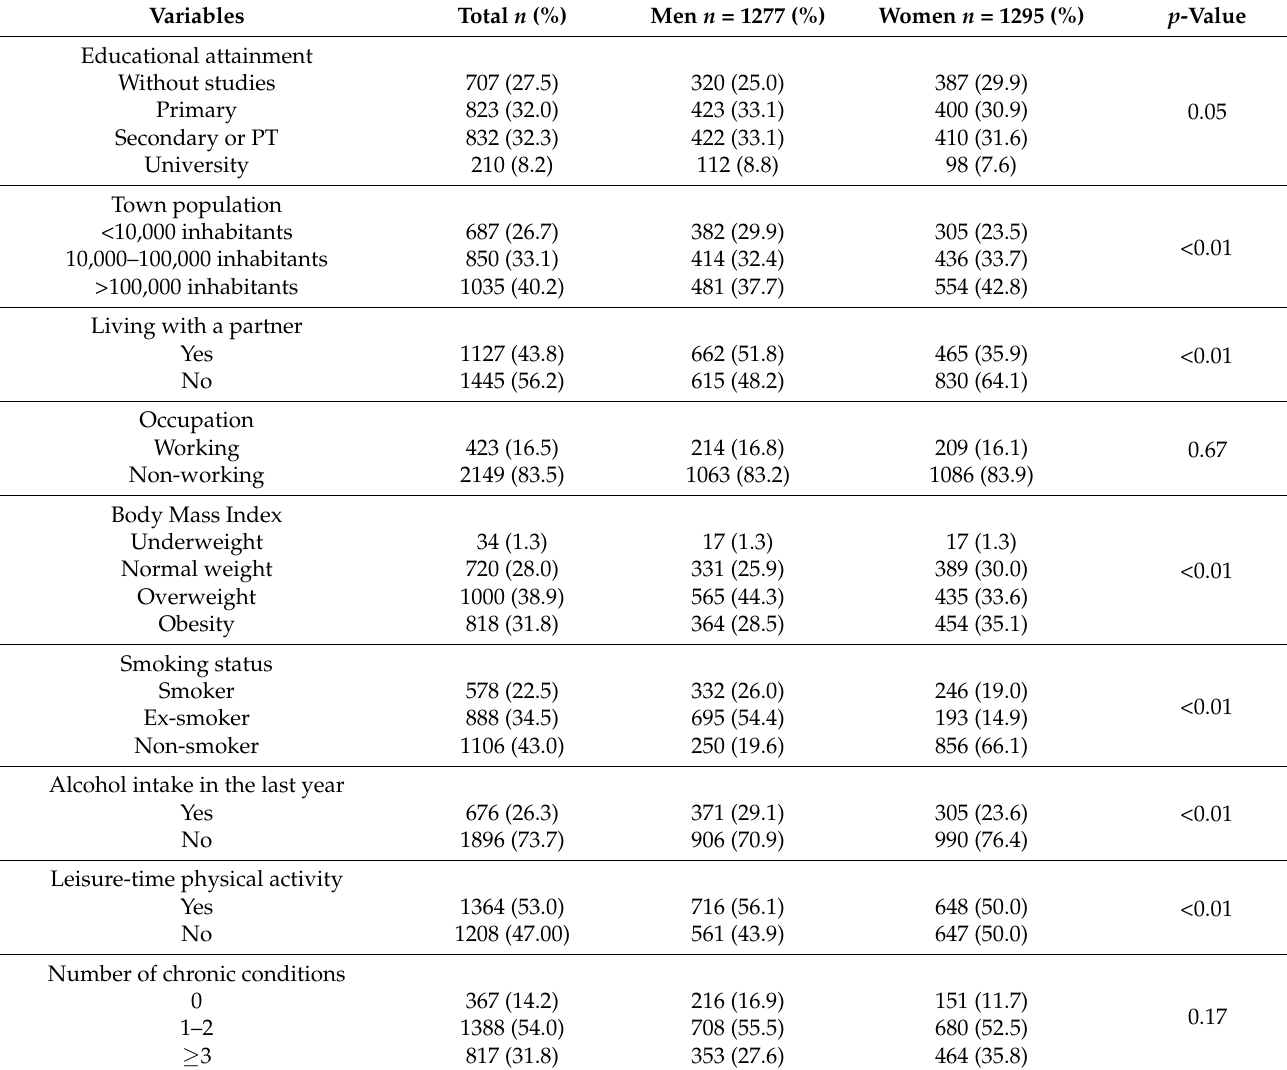
Table 1. Comparison of male and female COPD patients as regards sociodemographic variables, health-related determinants and the use of clinical preventive care services ( n =